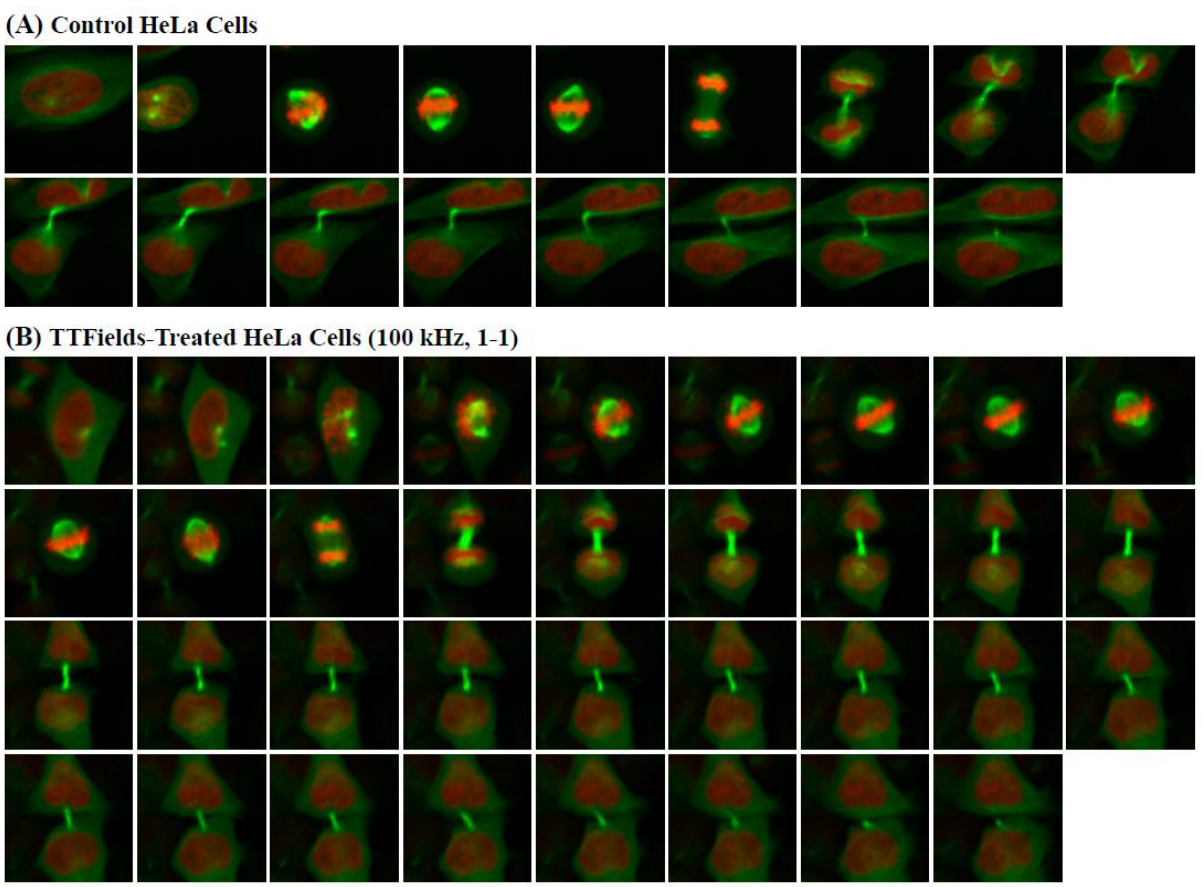
Figure 4. A total of 3 × 10 4 HeLa cells were seeded on a coverslip of a 35 mm ibidi dish and allowed to adhere overnight. Cells were synchronized in the G1/S phase by a single thymidine block and then released for 6 h before imaging. Cells were maintained in an atmosphere of 5% CO 2 with an ambient temperature of 37 °C for the control cells and 23 °C for the TTFields-treated cells. ( A ) Representative images of unexposed HeLa cells acquired every 10 min throughout cell division. ( B ) Representative images of TTFields-treated HeLa cells (100 kHz, 1-1 duty cycle) acquired every 10 min throughout cell division.